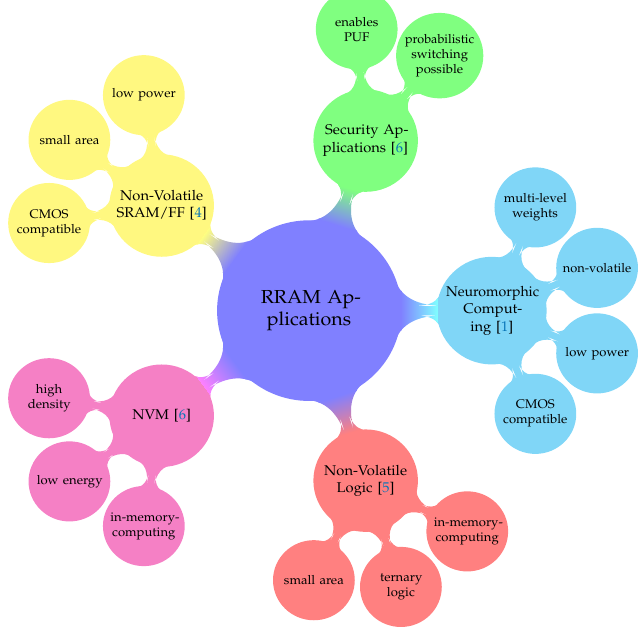
Figure 1. Resistive Random Access Memory (RRAM)